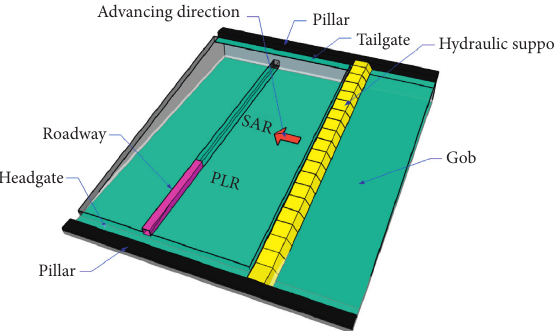
Figure 1: Longwall face striding across and passing through a